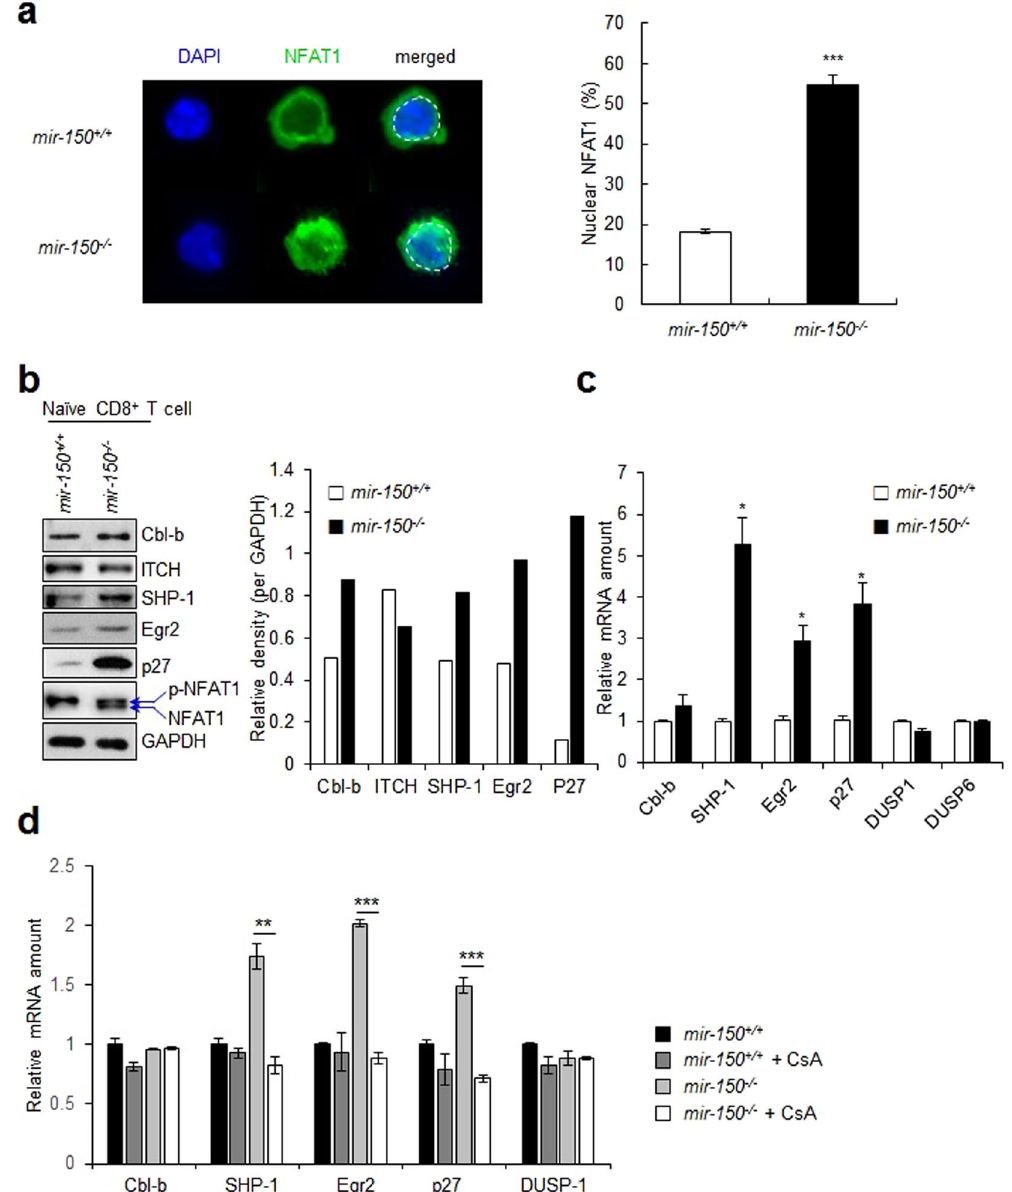
Figure 3. miR-150 deficiency induces the expression of anergy-related genes in naïve CD8 + T cells. ( a ) The level of nuclear localization of NFAT1 in mir-150 + / + and mir-150 − / − naïve CD8 + T cells after incubation under Ca 2 + (2 mM) for at 20 min. The images are the representative samples (left) and the level of nuclear localization of NFAT1 (right). ( b ) The expression level of anergy-related genes and phosphorylation status of NFAT1 in naïve mir-150 + / + and mir-150 − / − CD8 + T cells after incubation in 2 mM Ca 2 + containing media (left) and the calculated expression levels (right). Western data are the cropped blot images representing indicated proteins. ( c ) Relative expression level of anergy-related and Egr2-related gene in mRNA levels in mir-150 − / − naïve CD8 + T cells compared with those in mir-150 + / + naïve CD8 + T cells. ( d ) The effect of inhibition of NFAT translocation on the expression levels of anergy-related genes in mir-150 + / + and mir-150 − / − naïve CD8 + T cells. Isolated mir- 150 + / + and mir-150 − / − naïve CD8 + T cells were incubated with or without cyclosporine A (CsA, 3 µ M) for 12 h and the amount of anergy-related mRNAs were measured using RT-PCR * P < 0.05, ** P < 0.01, *** P < 0.001. Data are means ± SEM of duplicate triplicate samples from a single experiment and are representative of two independent